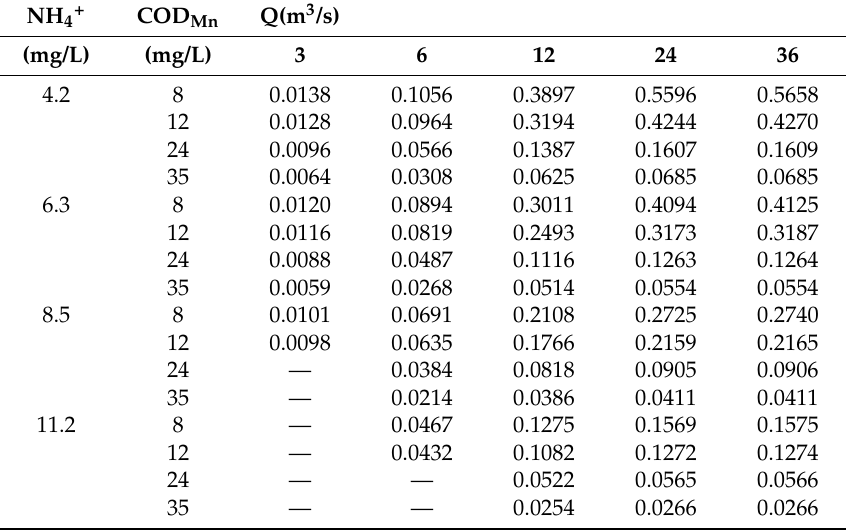
Table 9. The typical values of combined exceedance probability of NH 4+ and COD Mn